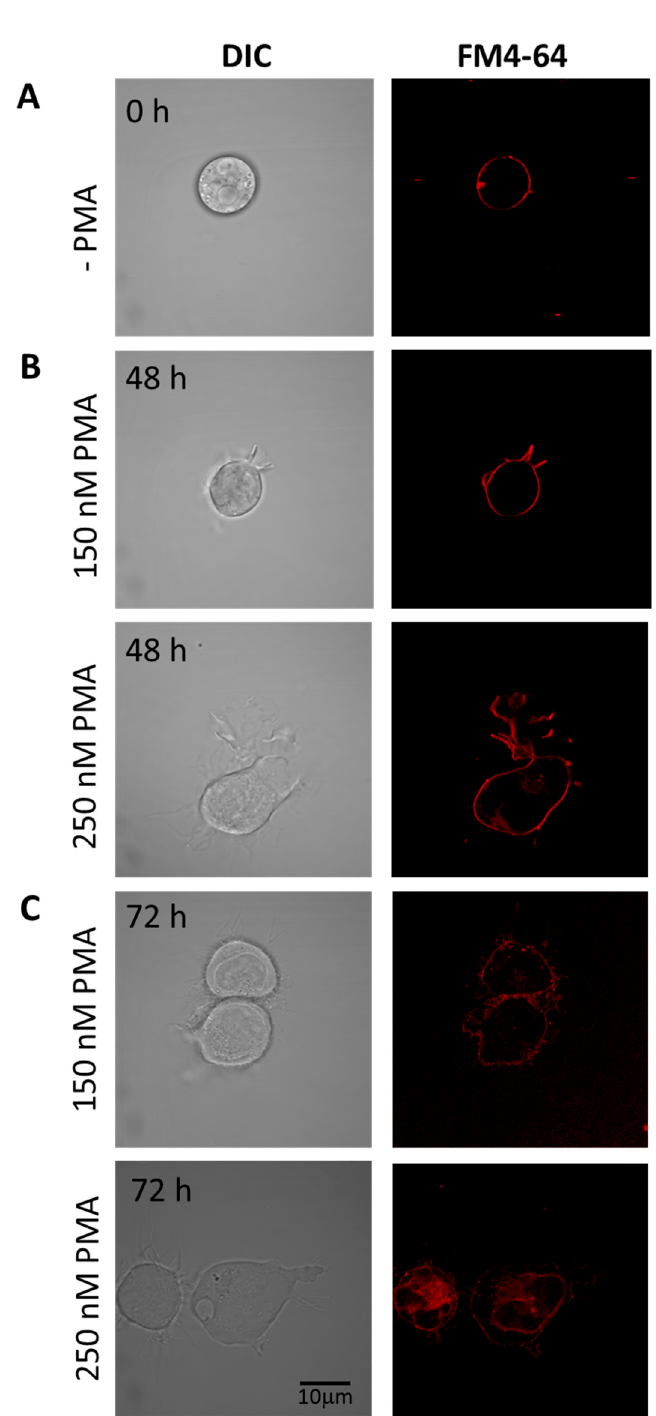
Figure 3. Staining of U-937 cells with FM4-64 (5 min, RT) to check membrane integrity in non-differentiated ( A ) and differentiated cells for 48 h ( B ) and 72 h ( C ). In both B and C, the upper panel shows U937 cells treated with 150 nM PMA, while the lower panels are cells treated with 250 nM PMA. Individual channels for DIC and FM4-64 (red signal) are presented.